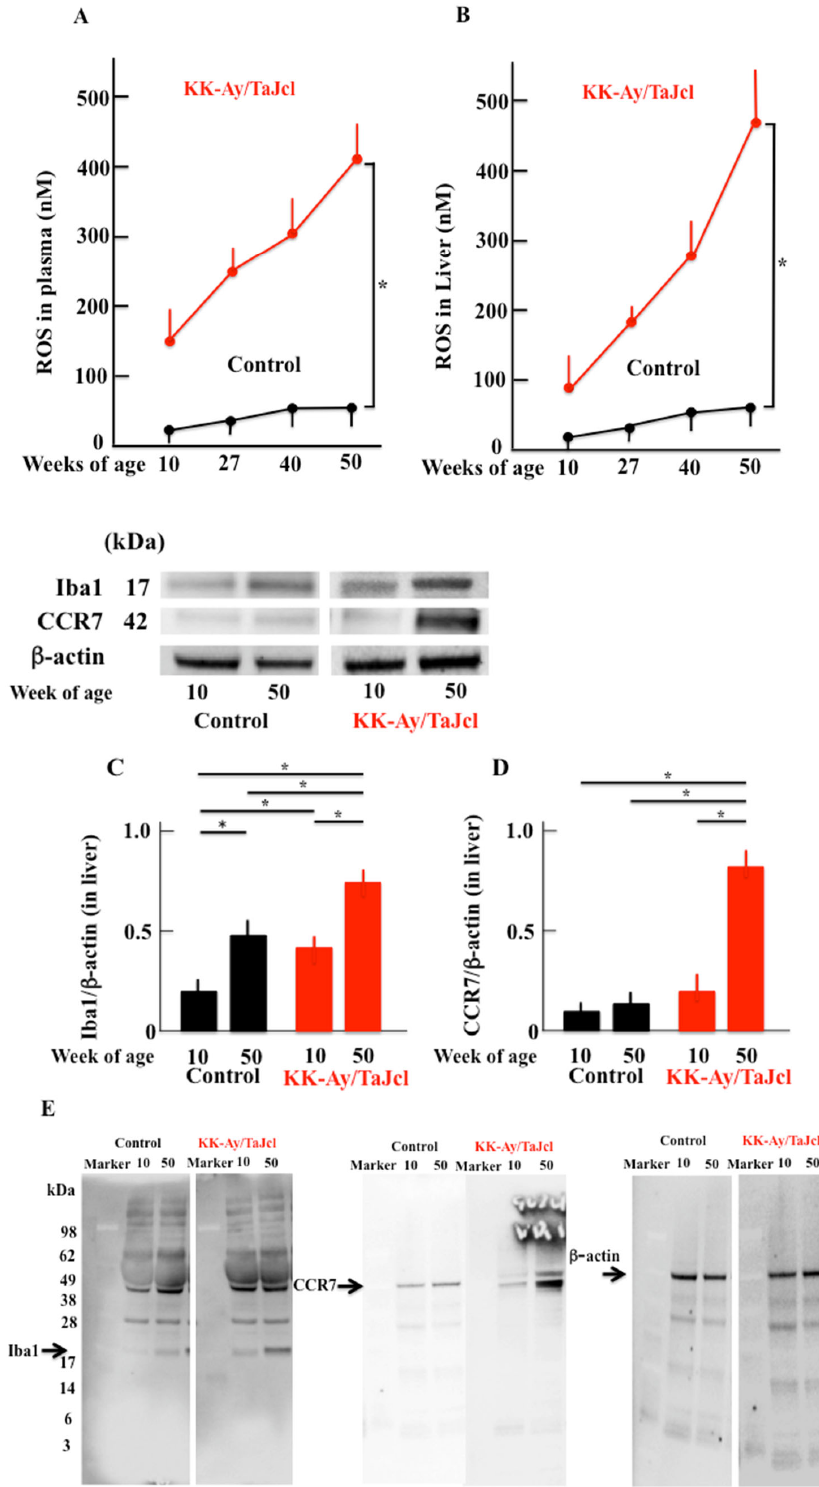
Figure 7. Effect of aging on ROS levels in the skin ( A ) and liver ( B ); and the expression of Iba1( C ) and CCR7 ( D ) in KK-Ay/TaJcl mice compared with the control. Western blot diagram of Iba1, CCR7, and β -actin with molecular weight markers ( E ). We measured the levels of ROS using a commercial kit and Western blotting for the analysis of Iba1 and CCR7. Values are expressed as the mean ± SD derived from five animals. * p < 0.05. Control: C57BL/6j mice.